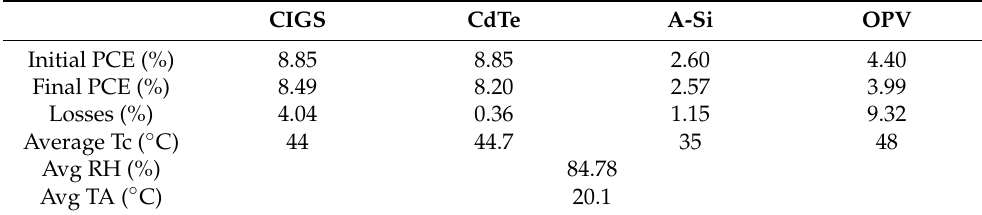
Table 8. PCE losses for PV technologies in PVMS3 after four